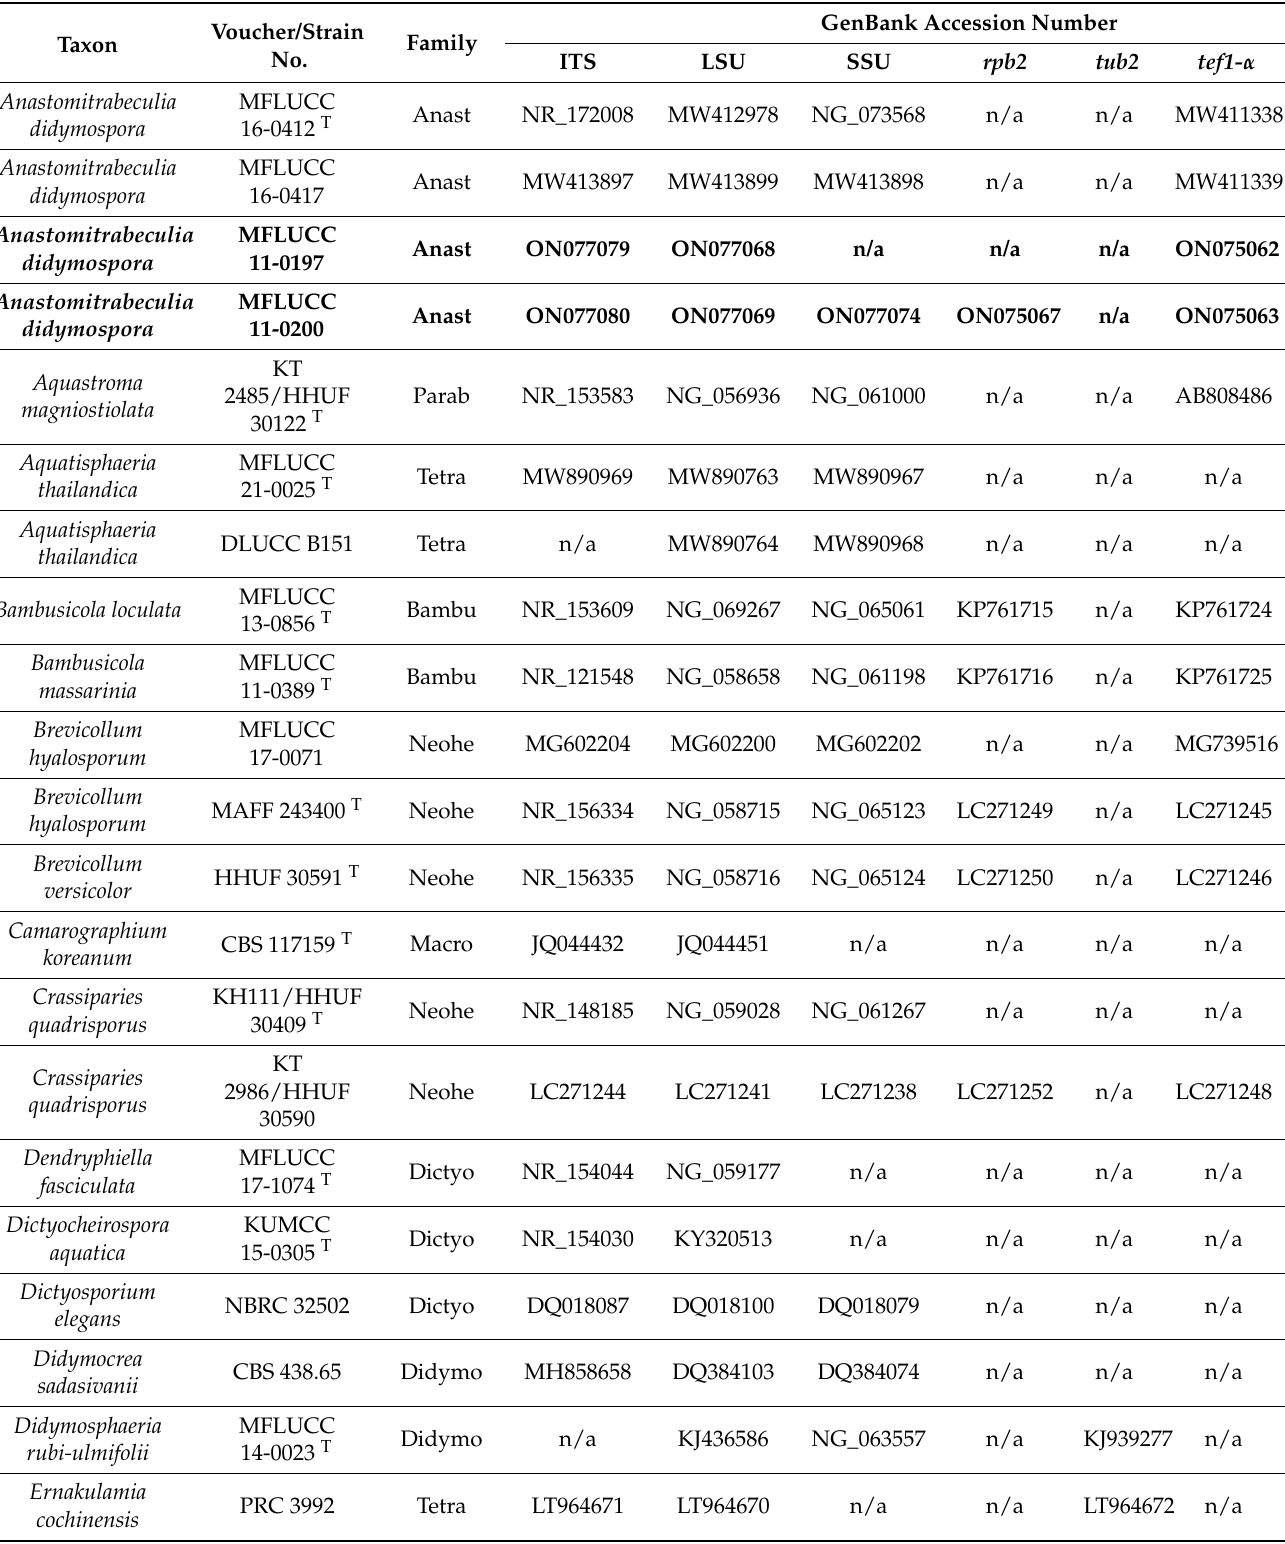
Table 1. GenBank accession numbers used in the phylogenetic analyses. The ex-type cultures are indicated with superscript “ T ”, and the newly generated sequences are indicated in